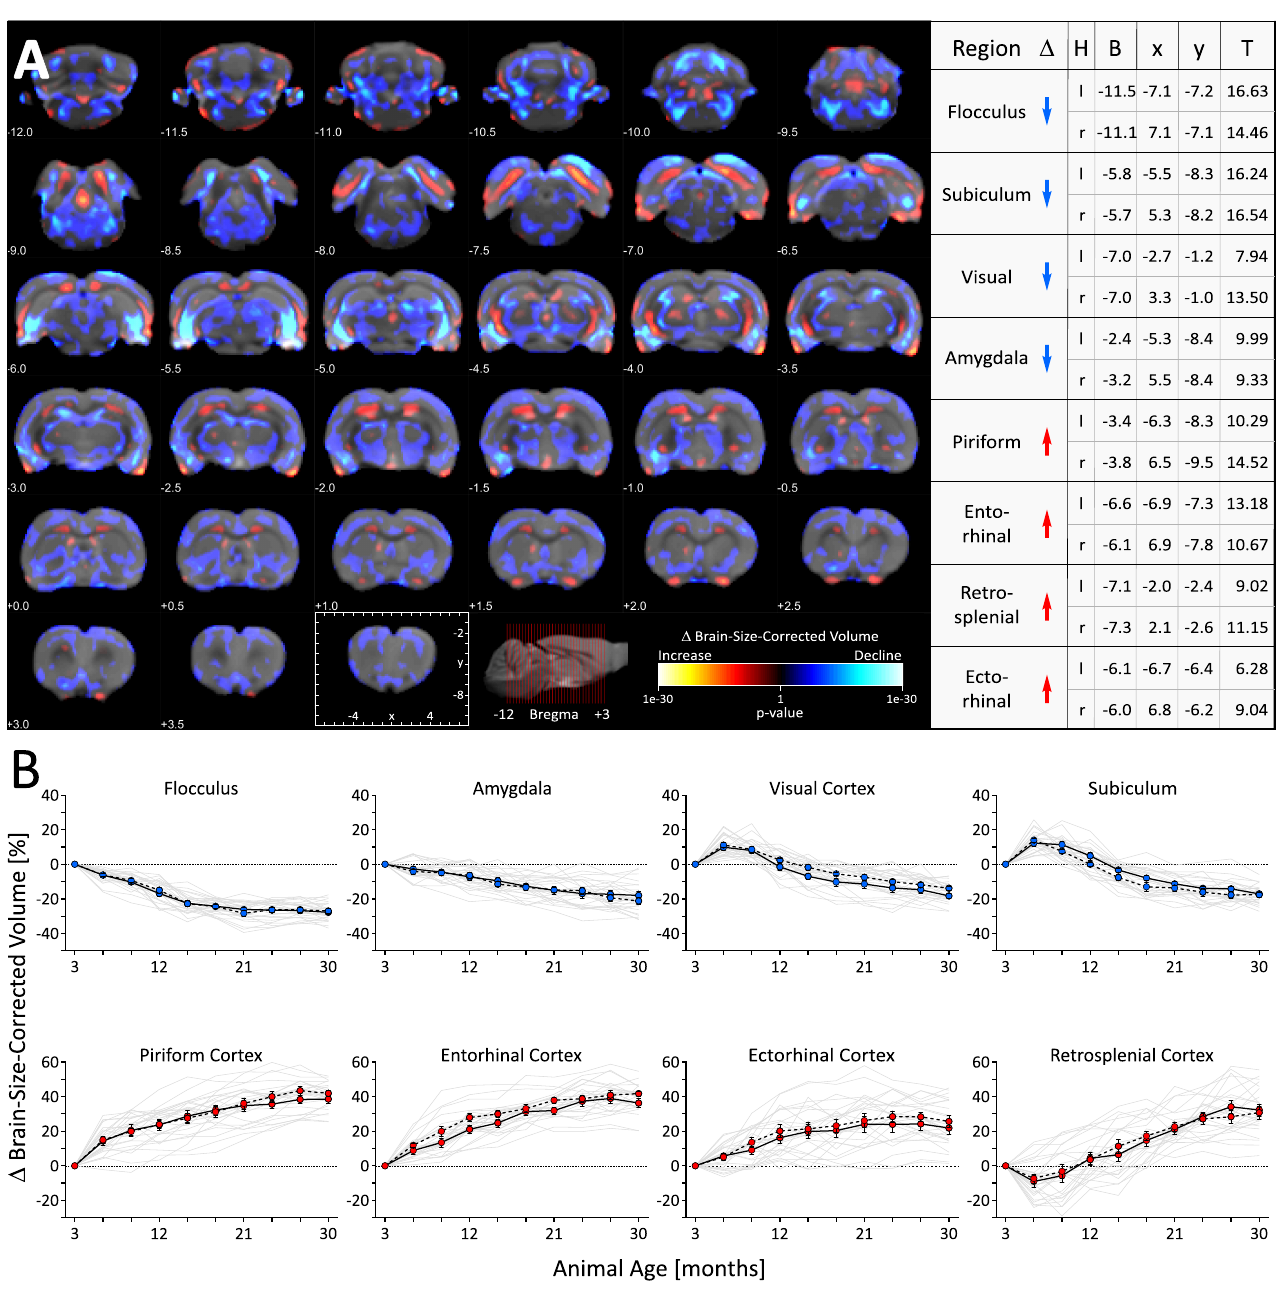
Figure 3. Voxel-wise analysis of whole brain morphological changes in male RccHan:WIST rats across their lifetime. ( A ) Statistical parametric maps demonstrating the spatial heterogeneity in aging-related macro-structural alterations. Results of the RM ANOVA analyzing temporal changes in brain-size-corrected local volume (threshold of p < 0.01, corrected for family wise error (FWE)) are superimposed on coronal sections of the reference brain. Blue colors show regions for which the volume was changed below (henceforth termed “shrinkage”), and red colors show regions for which the volume was changed above (henceforth termed “growth”) the rate of whole brain volume change. ( B ) Quantification of aging-related percentage volume changes in the four most significant shrinking and growing brain areas. Individual data and the average from the left (solid line) and right hemisphere (dotted line) are shown as mean ± SEM. A total of n = 13 rats were included in the study. Region-specific analyses for temporal changes using one-way RM ANOVA with Tukey HSD as well as the uncorrected changes are shown in Supplementary Table S1D. Abbreviations: H: hemisphere; l/r: left/right; B,x,y: Bregma and xy-coordinates corresponding to the Paxinos Atlas; T: T-value RM ANOVA, threshold of p < 0.01, corrected for family wise error